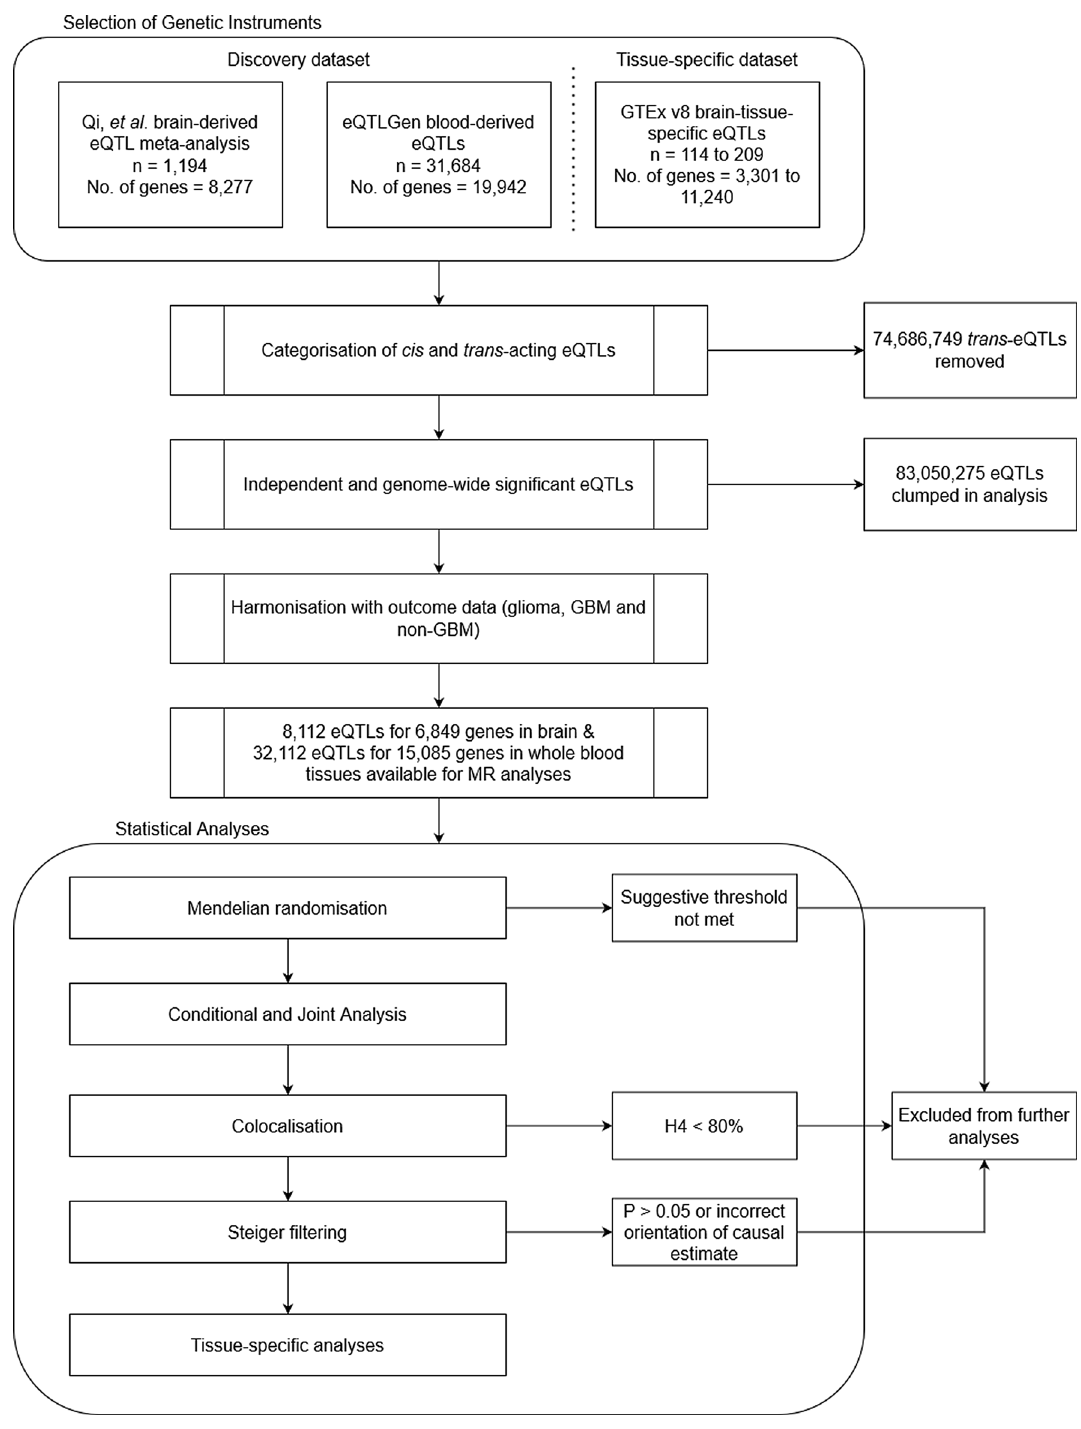
Figure 1. Schematic of the analysis pipeline we employed for this